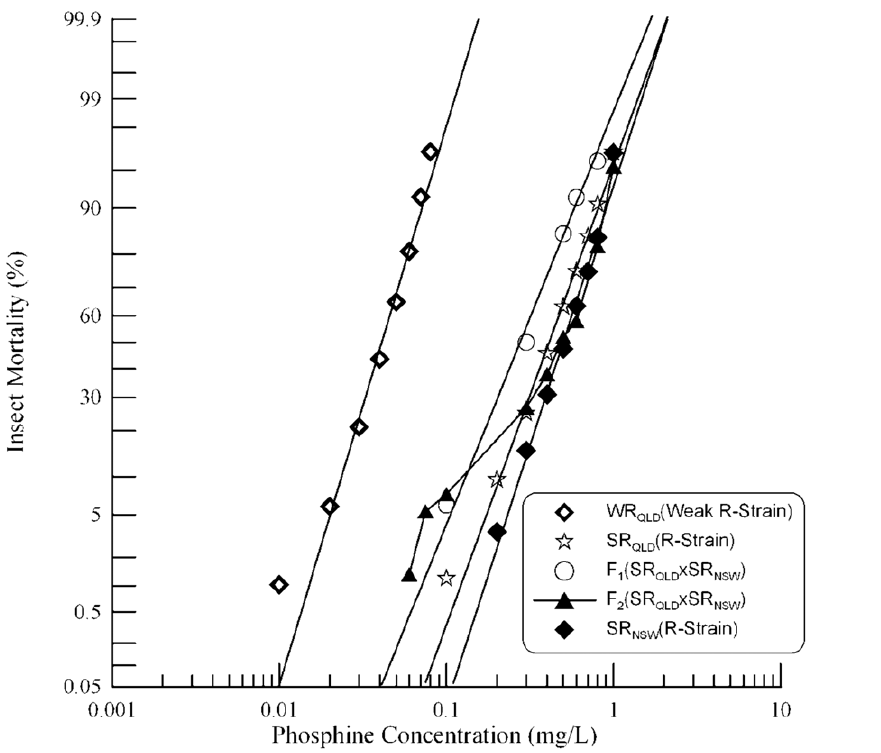
Figure 3. Resistance response of F 1 hybrids and F 2 progeny of a cross between strongly resistant R. dominica strains from Queensland and New South Wales. Results are presented as log-dose mortality of the F 1 hybrids and the F 2 progeny with reference curves of the parental strains, SR QLD and SR NSW , and the weakly resistant strain from Queensland (WR QLD ). Phosphine exposure was for 48 hours at 25 u C and 70%